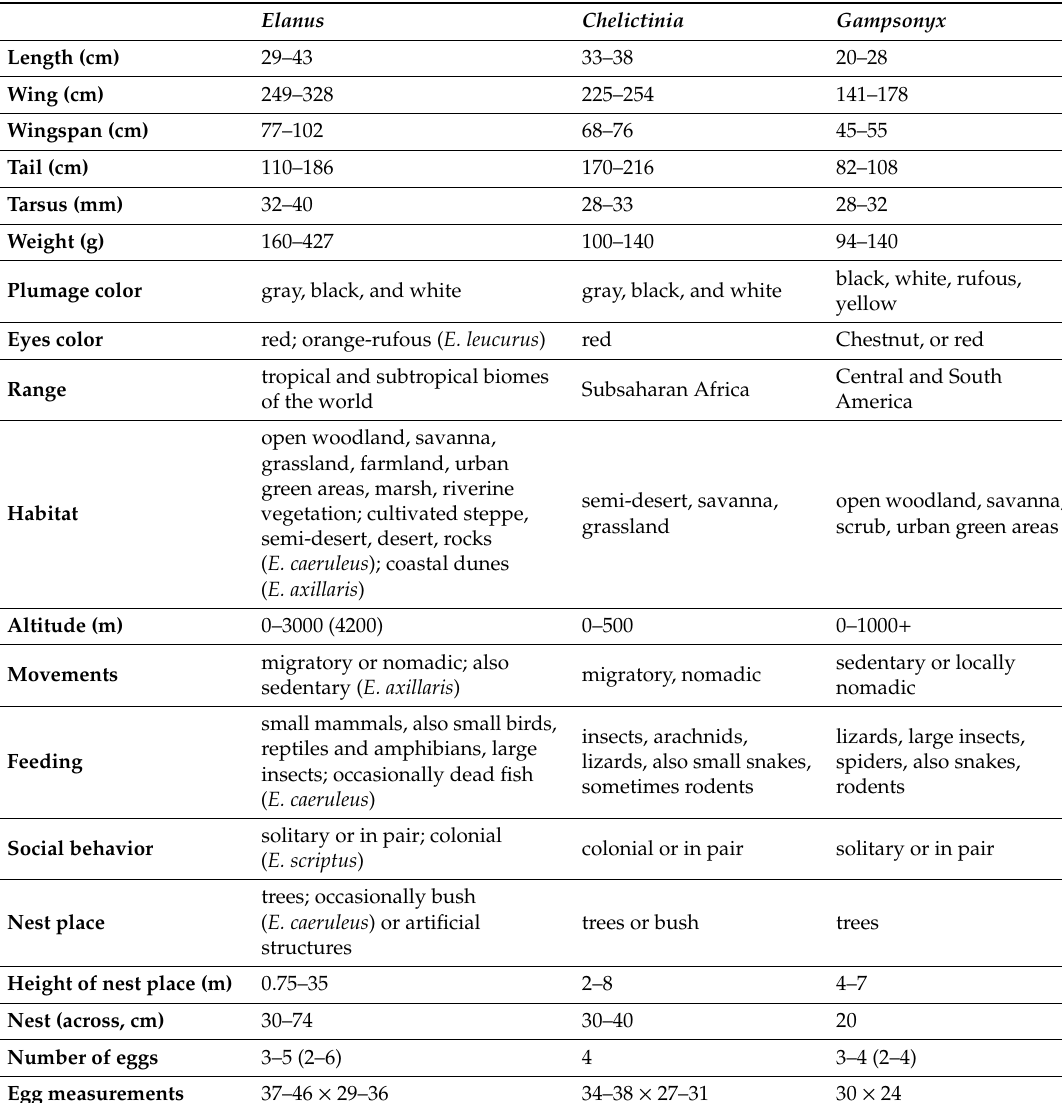
Table 4. Characteristics of elanin